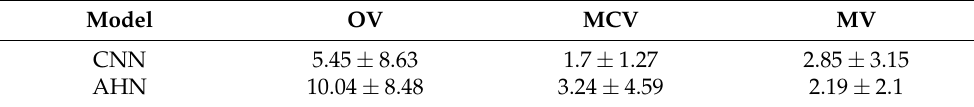
Table 8. PE ± σ PE for the CNN and AHN